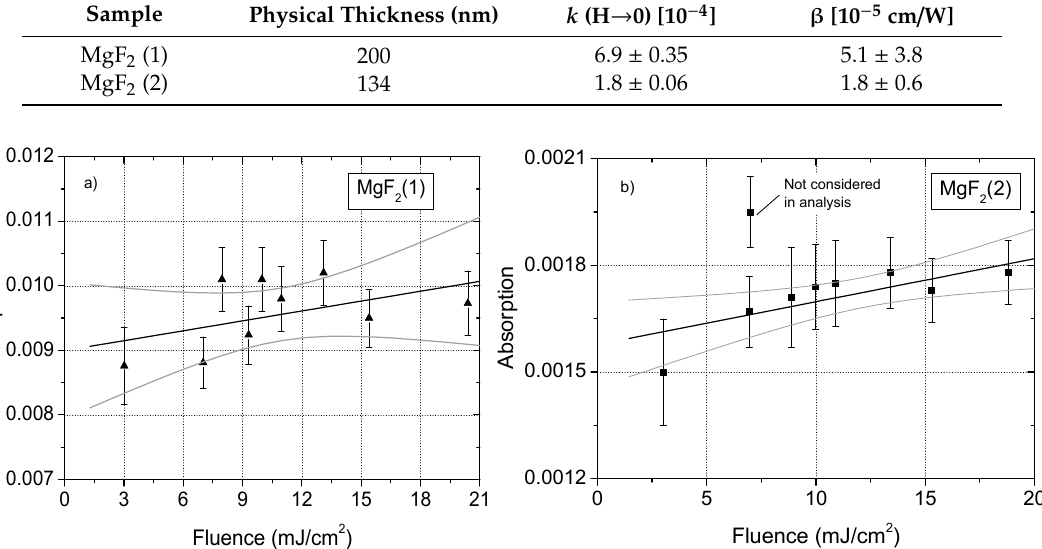
Table 1. Linear absorption k and two-photon absorption coefficient β of the investigated MgF 2 single layers. Sample